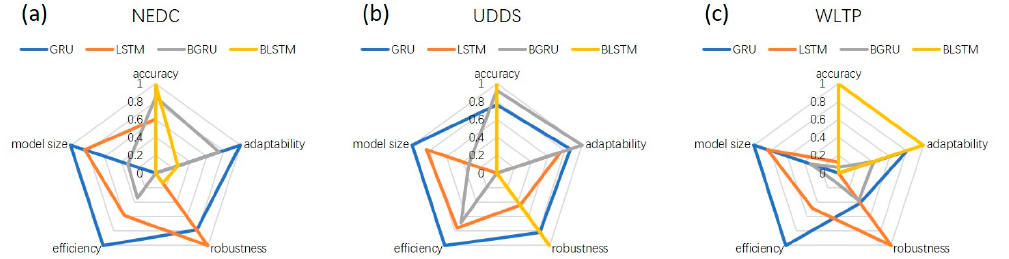
Figure 7. Comprehensive performance of different RNNs: ( a ) test under NEDC conditions; ( b ) test under UDDS conditions; ( c ) test under WLTP conditions.